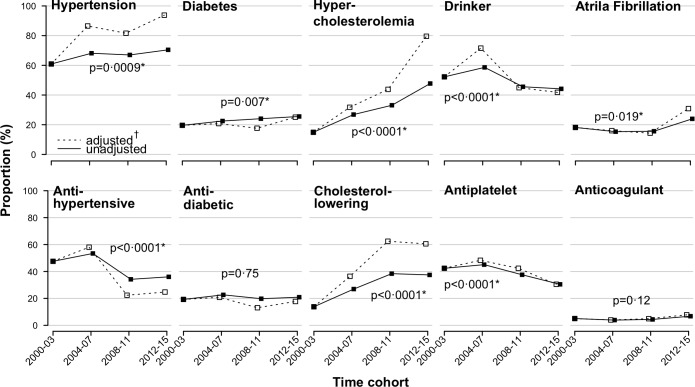
Prior risk factors and medication use over time in patients with incident first-ever IS.p-Values were obtained by the Cochran-Armitage tests for trend and are presented for the unadjusted rates. * denotes significant trends (p < 0.05). † adjusted for age, sex, and ethnicity, allowing for interaction between time and ethnicity as appropriate. IS, ischaemic stroke.